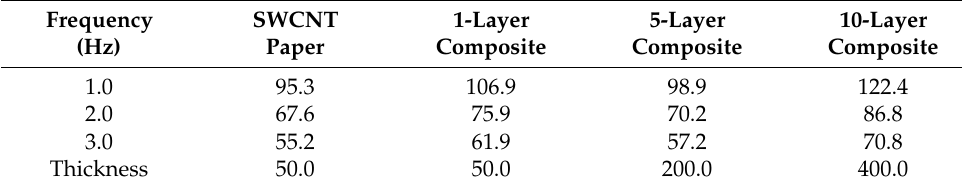
Figure 7. Calculated skin depth according to frequency of the SWCNT paper and 1-, 5-, and 10- layer composites. Table 1. Calculated values of skin depth ( μ m).